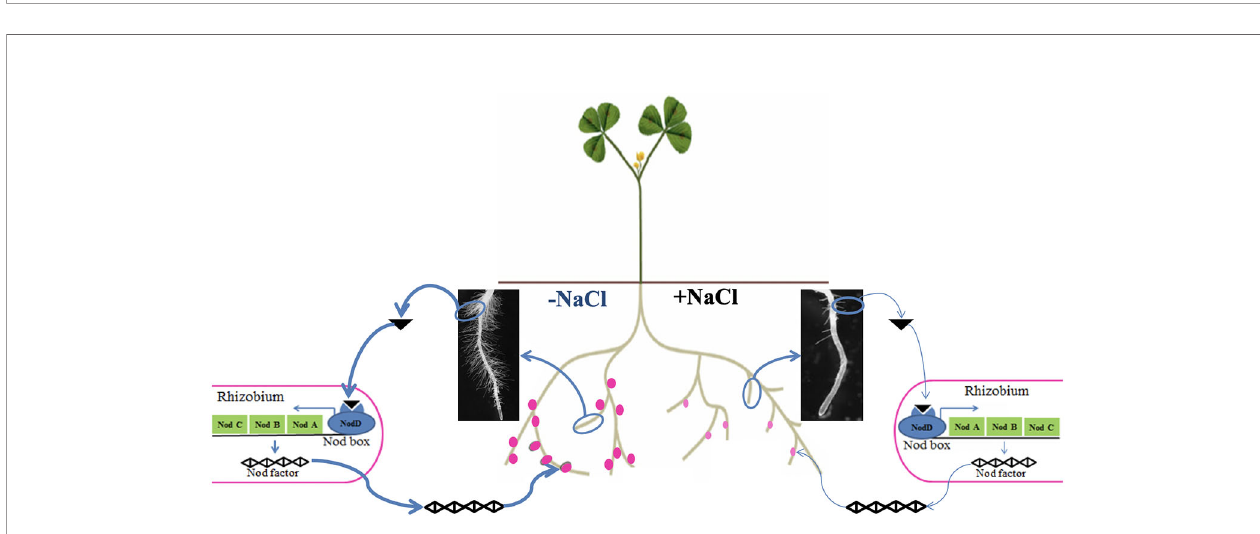
FIGURE 4 | Conceptual illustration of the effect of salt stress on the establishment and functioning of legume – rhizobium symbiosis. Under nitrogen de fi ciency, without salt stress the legume emits many (bold arrow) chemical cues in the form of iso fl avonoids (black triangle) to speci fi cally attract rhizobia, which in turn secrete Nod factors allowing recognition between the two partners and formation of functional nodules (dark pink dots). However, salt stress negatively affects the legume – rhizobium dialogue by reducing iso fl avonoid secretion (thin arrow) leading to less nodulation (number and biomass) and nodule function (pale pink dots).